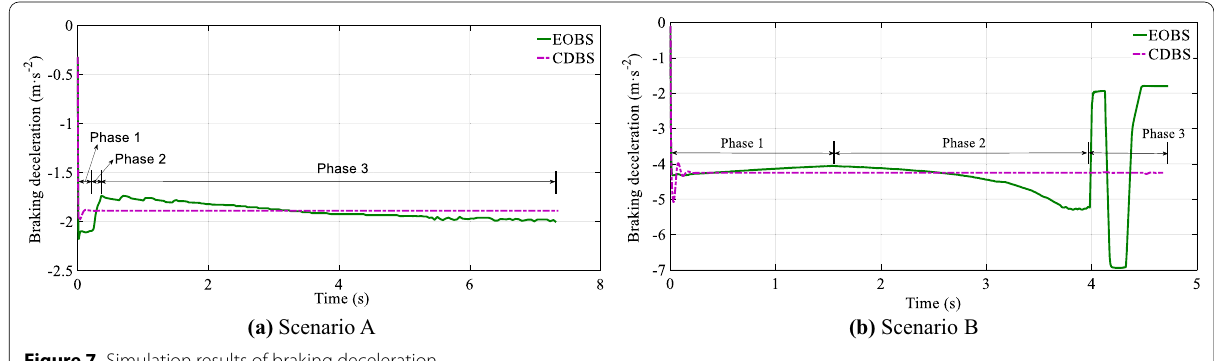
Regeneration energy efficiency α r (%)